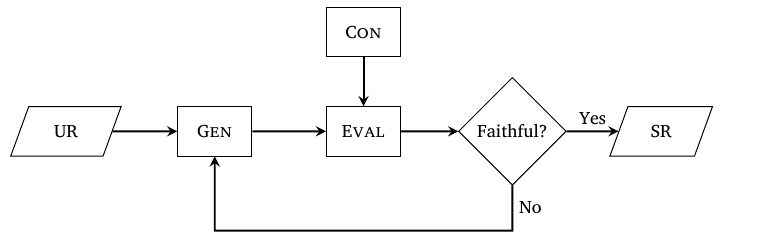
Figure 3: Harmonic